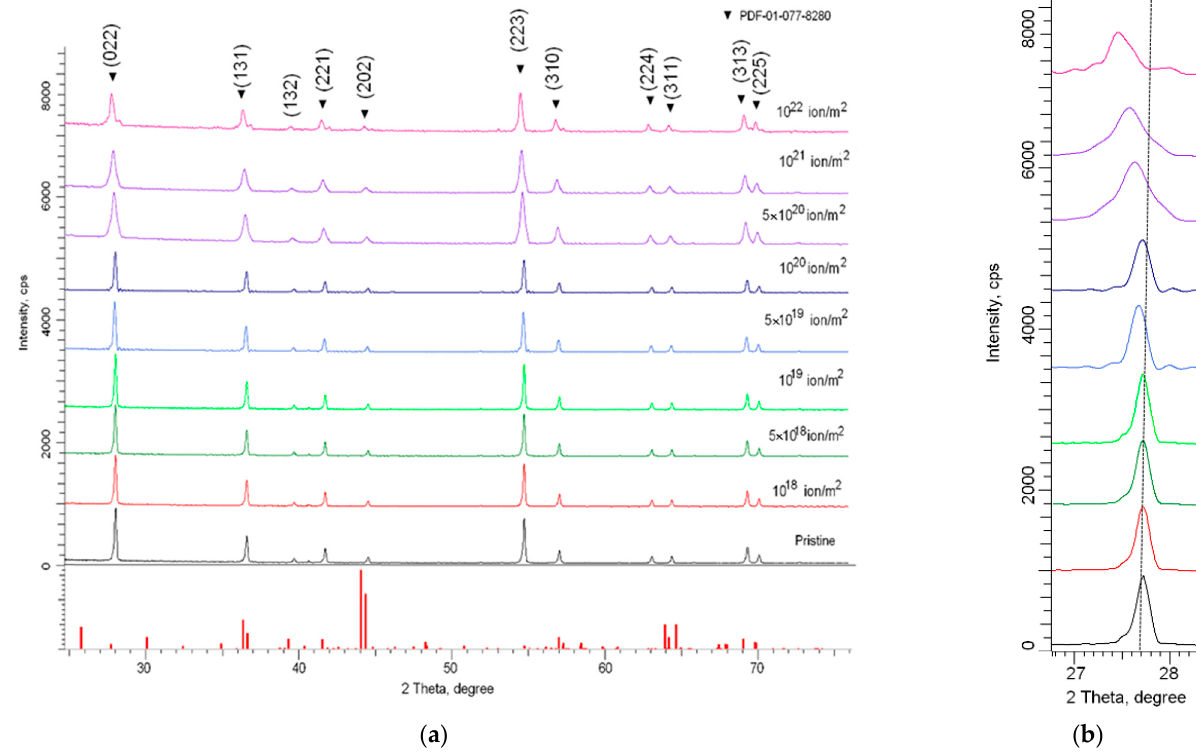
Figure 2. ( a ) X-ray diffraction patterns of the studied ceramics depending on the irradiation fluence; ( b ) dynamics of changes in the main reflex at 2 θ = 27.7°.